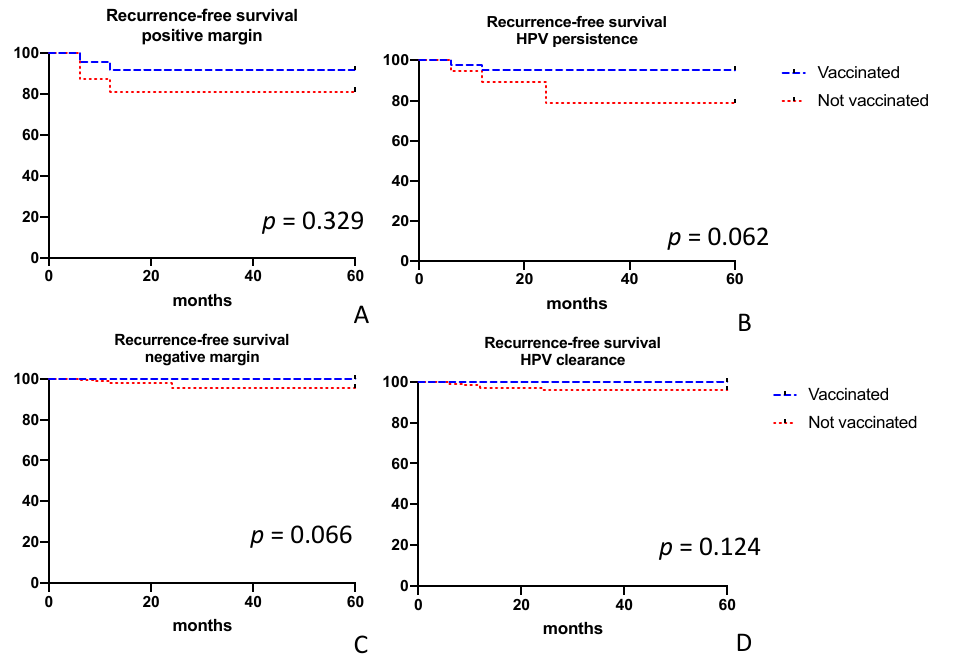
Figure 3. Recurrence rate according to various risk factors: positive margins ( A ), HPV persistence ( B ), negative margins ( C ), and HPV clearance ( D ). Table 1. Baseline characteristics of the population.